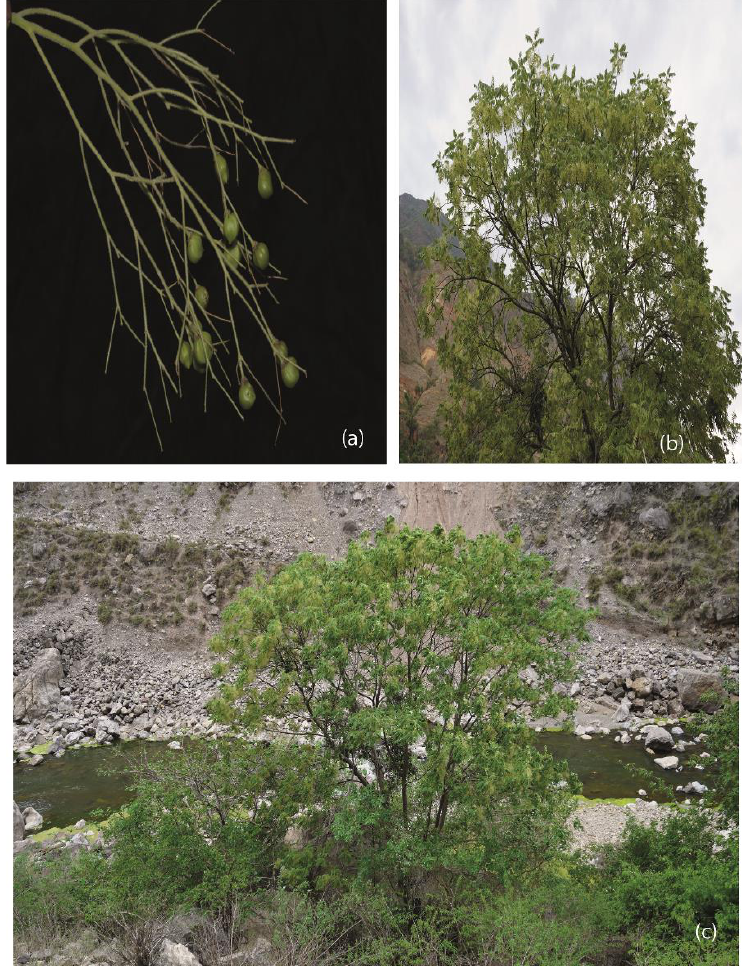
Figure 1. Landscape and botanical features of Garuga forrestii in China: ( a ) fruits; ( b,c ) trees in bloom and tree form in Yunnan.